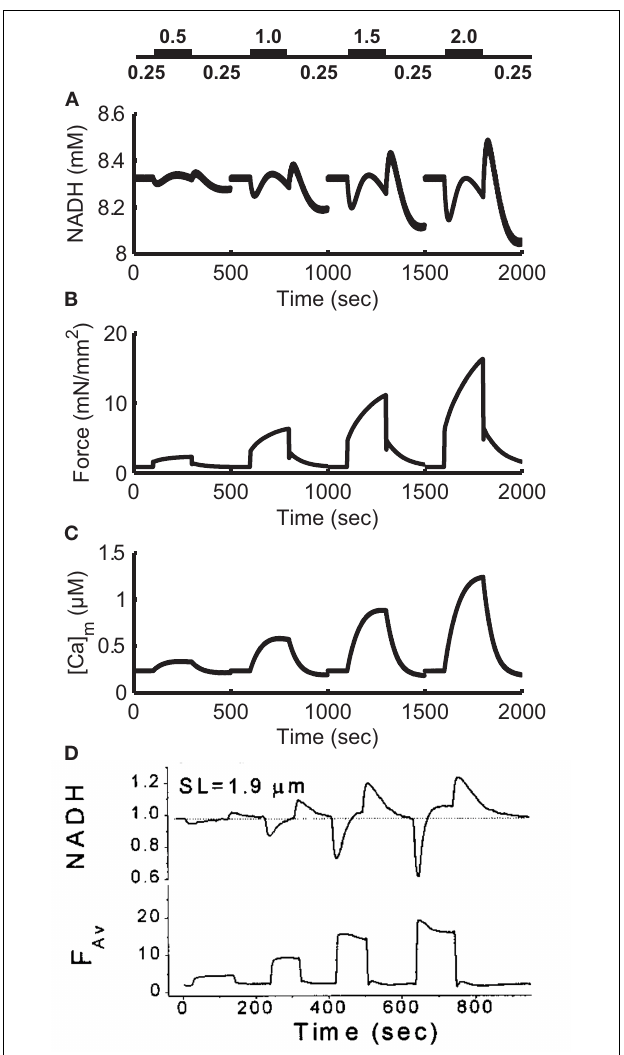
FIGURE 12 | Frequency-dependence of NADH levels. (A) Simulation of NADH concentration for a pacing protocol consisting of 100s at 0.25Hz [see labels above (A) ], 200s at higher pacing frequencies of 0.5, 1.0, 1.5, and 2.0Hz then 200s recovery at 0.25Hz. Each 500s protocol is started from 0.25Hz steady-state initial conditions. (B) Moving average of model force output using a 4000-ms window. Force ranges from approximately 0.9mN/mm 2 at 0.25Hz to 16.4mN/mm 2 at the end of the 2-Hz pacing period. (C) Model mitochondrial Ca 2 + concentration. (D) Experimental